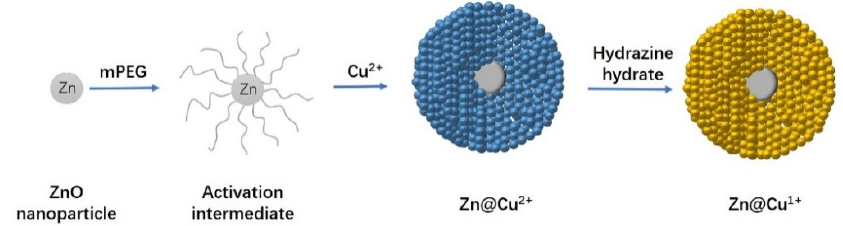
Scheme 1. Illustration of formation of xZnO@yCu 2 O.